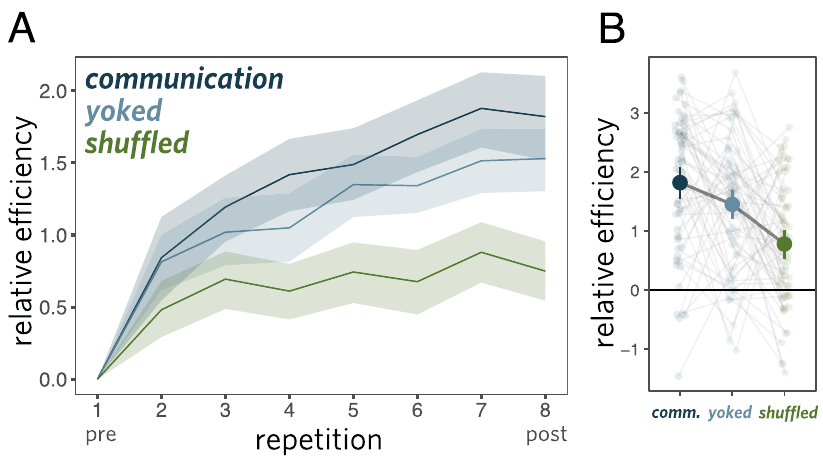
Fig. 5 | Performance on recognition experiment. A Comparing drawing recog- nition performance between viewers in communication experiment (dark blue) with those of yoked (light blue) and shuf fl ed (green) control groups. B